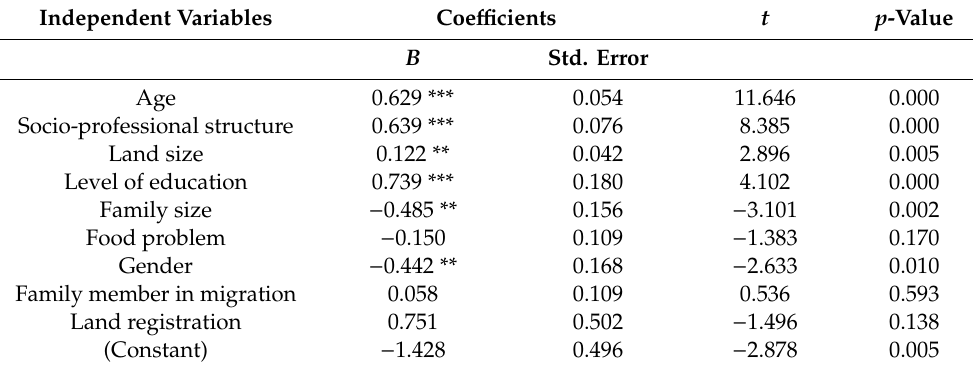
Table 3. Impacts of selected variables on